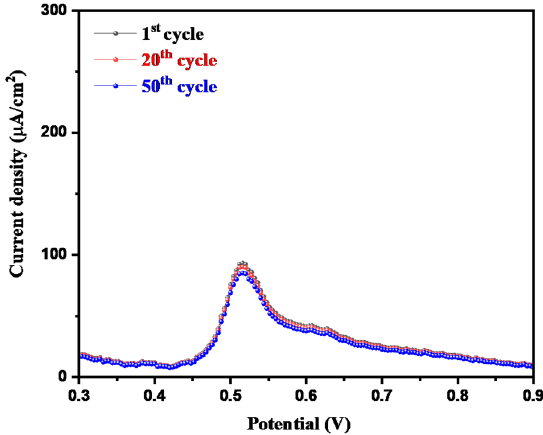
Figure 10. DPV patterns (1st, 25th, and 50th) of S@rGO/GCE in presence of 100 µM acetaminophen in 0.1 M PBS (pH = 7.0; scan rate = 50